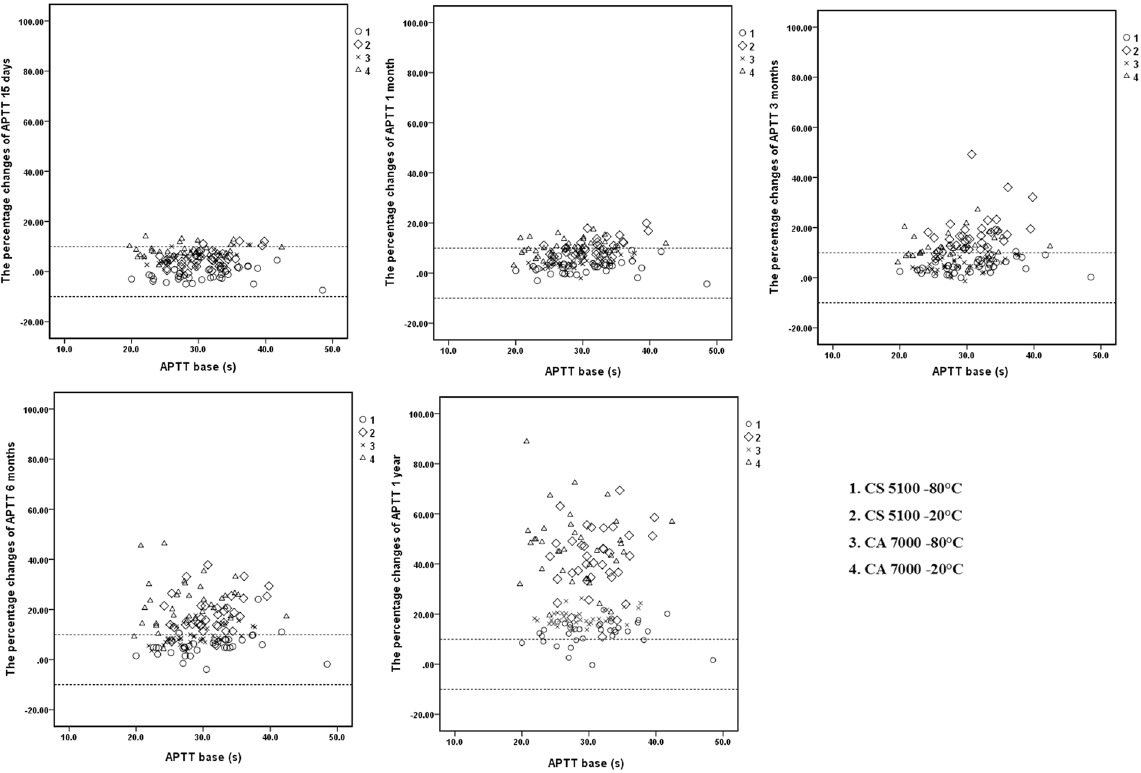
Figure 2. Percent changes of APTT in samples stored for 15 days, 1 month, 3 months, 6 months, and 1 year and detected by the CS5100 and CA7000 systems.1: Samples stored at − 80 °C and analysed by the CS5100